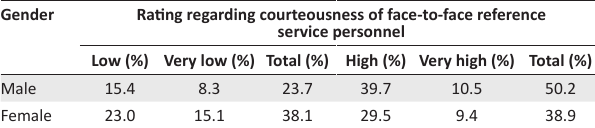
TABLE 6: Courteousness of face-to face-reference service personnel Gender Rating regarding courteousness of face-to-face reference service personnel